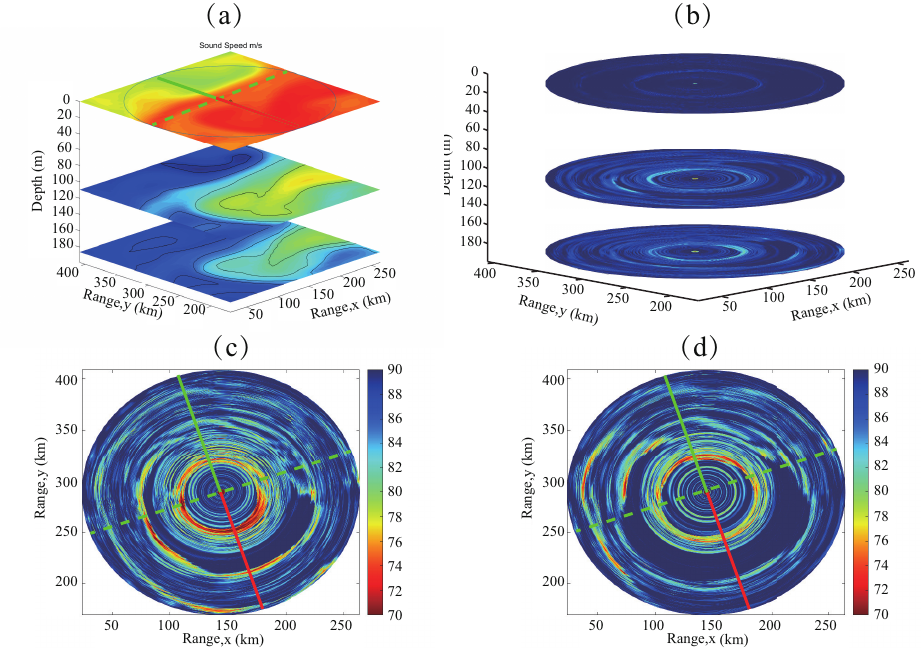
Figure 19. ( a ) Three dimensional structure of the oceanic front, ( b ) Transmission Losses 3-D for depths 0 m, 100 m and 200 m, ( c , d ) Transmission Loss slice for depth 100 m and 200 m.